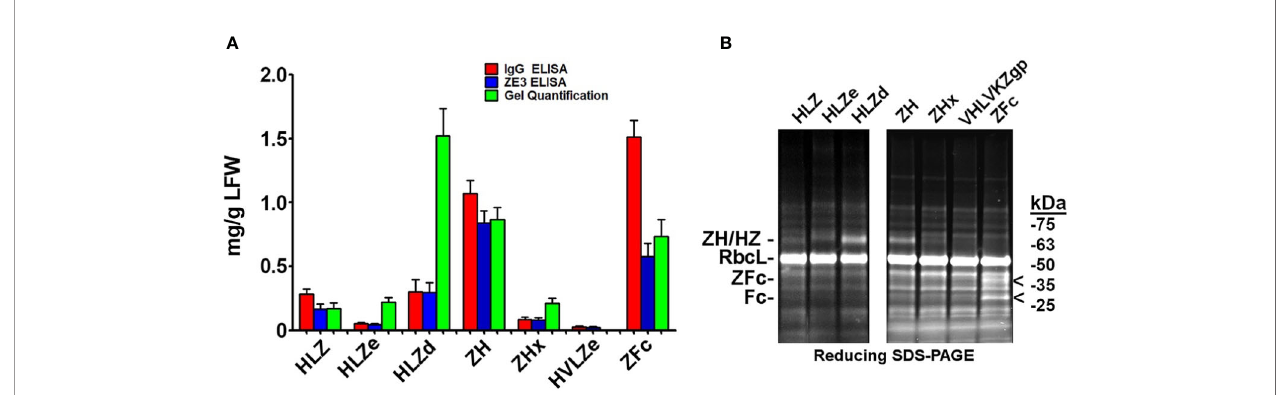
FIGURE 2 | Modi fi ed IgG fusions have improved expression and solubility (A) . ELISA and gel quanti fi cation of IgG fusion construct expression. Clari fi ed protein extracts ( “ soluble ” fraction) from leaf spots agroin fi ltrated with each IgG fusion construct were analyzed by either ELISA, or SDS-PAGE followed by gel image quanti fi cation. For ZE3 ELISA, plates were coated with polyclonal mouse anti-ZE3, incubated with serial dilutions of extracts from each IgG fusion using puri fi ed HLZ as a standard, and probed with goat anti-human IgG-HRP. For IgG ELISA, plates were coated with serial dilutions of extracts or human IgG standard and probed with goat anti-human IgG-HRP. For gel quanti fi cation, ImageJ software was used to compare the IgG fusion band intensity visualized on stain-free polyacrylamide gels using puri fi ed 6D8 antibody as standard. Columns represent means ± standard error from three independently in fi ltrated leaf samples (B) . Clari fi ed leaf extracts were separated by reducing SDS-PAGE and a representative gel image is shown. The general band position corresponding to each respective heavy chain/ZE3 fusion is indicated “ ZH/HZ. ” The small shift in size in HLZe (~67 kDa of the reduced heavy chain fusion before glycosylation) and HLZd (~65 kDa) or HLZ (~64.5 kDa) is due to epitope tag truncation. ZH and ZHx have a predicted size of ~64.5 kDa. The “ < “ indicates ZE3-Fc (~40 kDa) and Fc (~29 kDa) fragments. The large subunit of Rubisco is abbreviated “ RbcL ” .